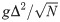
Robustness of the transient coding scheme and capacity of the network.(A-B-C) Robustness of the readout activity for a single stored pattern u-v in presence of randomness in the connectivity with variance g2/N. A. Projection of the population activity elicited by input v along the readout u (red trace) and along a readout orthogonal to u (blue trace) for g = 0.5. The elements of the orthogonal readout are drawn from a random distribution with mean zero and variance 1/N and are fixed over trials. The projection of the activity on u is also shown for the zero noise case (g = 0; black dashed line). B. Value of the activity along u (red dots) and along the orthogonal readout (blue dots) at the peak amplification (t = t*), as a function of g. In A and B, N = 200; error bars correspond to the standard deviation over 100 realizations of the random connectivity. C. Standard deviation of the readout activity at the peak amplification as a function of the network size N for two values of g. The fluctuations are inversely proportional to the network size and scale as gΔ2/N. Error bars correspond to the standard deviation of the mean over 100 realization of the connectivity noise. (D-E-F) Robustness of the transient coding scheme in presence of multiple stored patterns. D. Projection of the population activity elicited by one arbitrary amplified input v(k) along the corresponding readout u(k) (red trace) and along a different arbitrary readout u(k′) (blue trace) for P/N = 0.02. The readout u(k′) was changed for every trial. The projection of the activity on u(k) is also shown when only the pattern u(k)-v(k) is encoded (P = 1; black dashed line). E. Value of the activity along u(k) (red dots) and along the readout u(k′) (blue dots) at the peak amplification (t = t*), as a function of P/N. In D and E
N = 200; error bars correspond to the standard deviation over 100 realizations of the connectivity matrix. F. Standard deviation of the readout activity (along u(k)) at the peak amplification as a function of the network size N for two values of P/N. The fluctuations are inversely proportional to the network size and scale as Δ3P/N. Error bars correspond to the standard deviation of the mean over 100 realizations of the connectivity noise.